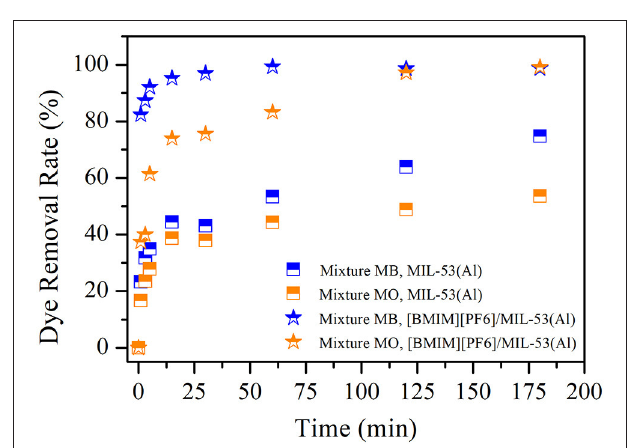
FIGURE 2 | MB and MO removal efficiencies of MIL-53(Al) (squares) and [BMIM][PF 6 ]/MIL-53(Al) (stars). Blue (orange) color represents MB (MO) removal for mixture dye. MB, methylene blue; MO, methyl orange.